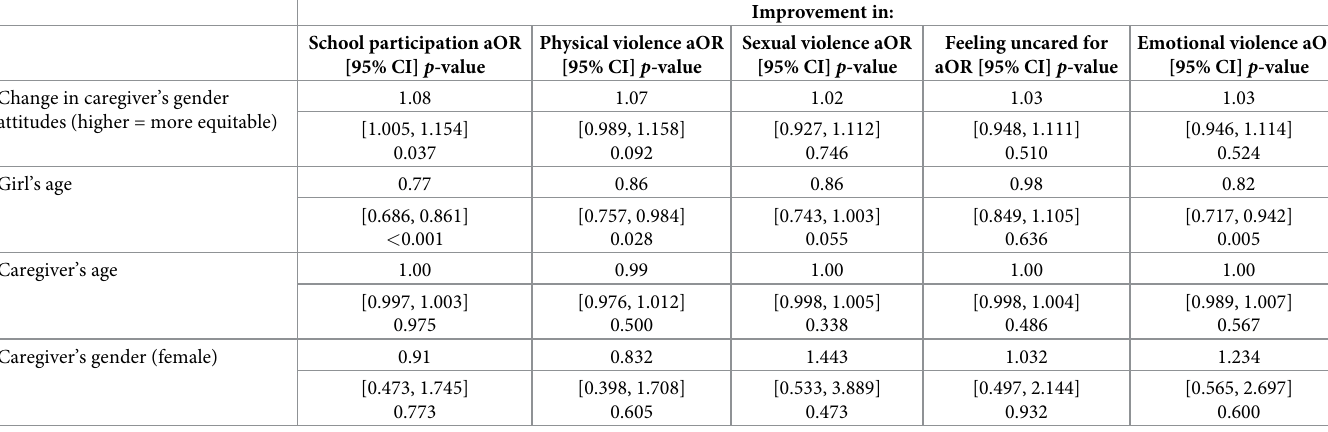
Table 3. Estimating changes in girls’ outcomes, adjusted odds